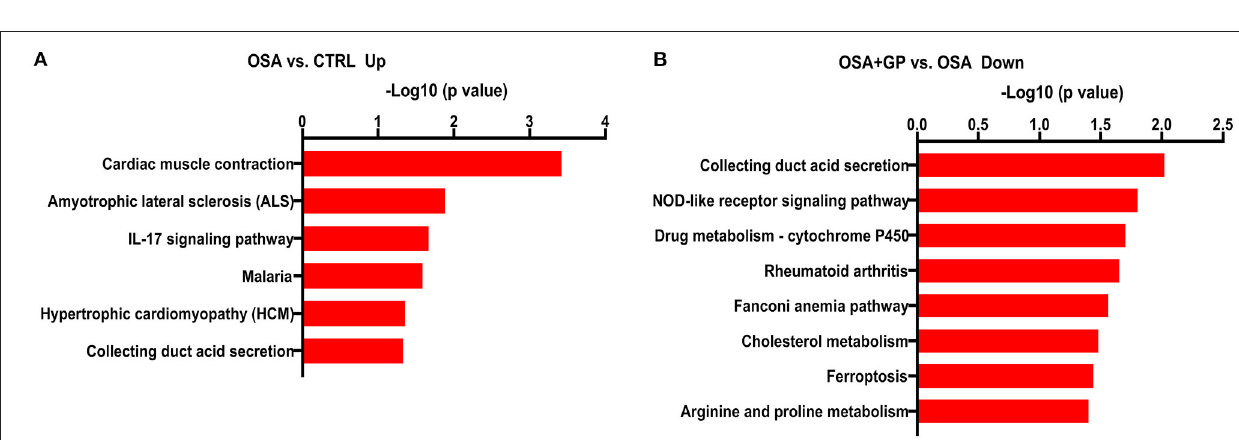
FIGURE 11 | Effect of SLGP ablation on the expression level of NGF, TH, and CHAT among the three groups. Representative immunohistochemical staining (A) and quantitative analysis of NGF, TH, and CHAT in LA (B) and SLGP (C) ; ** P < 0.01 vs. CTRL, ## P < 0.01 vs. OSA. NGF, neural growth factor; LA, left atrial; other abbreviations as in Figures 1 , 10 .